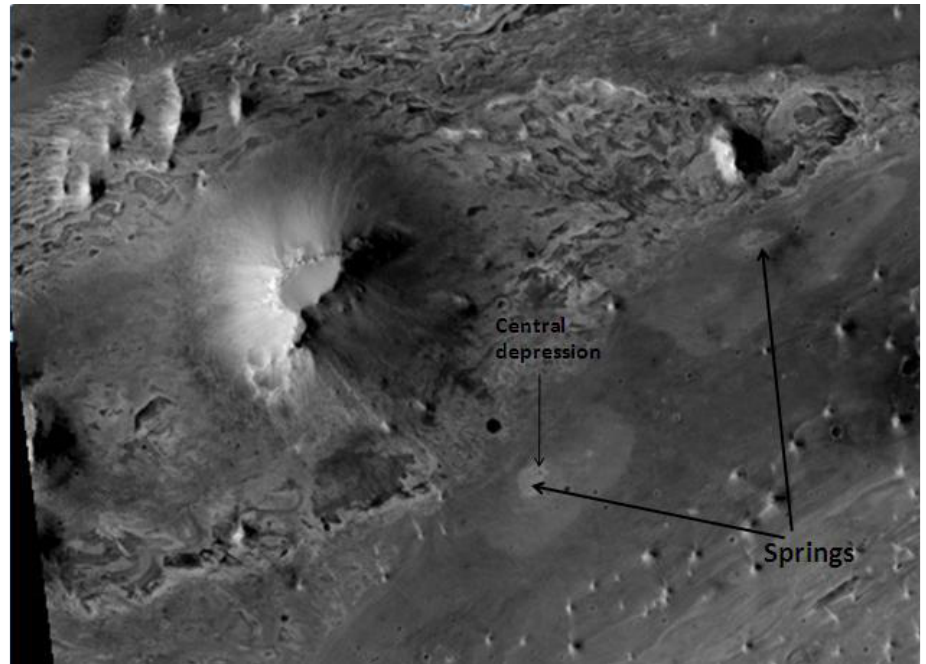
Figure 22. Springs in Vernal Crater, as seen by HiRISE. These springs may be good places to look for evidence of past life, because hot springs can preserve evidence of life forms for a long time. Location is the Oxia Palus